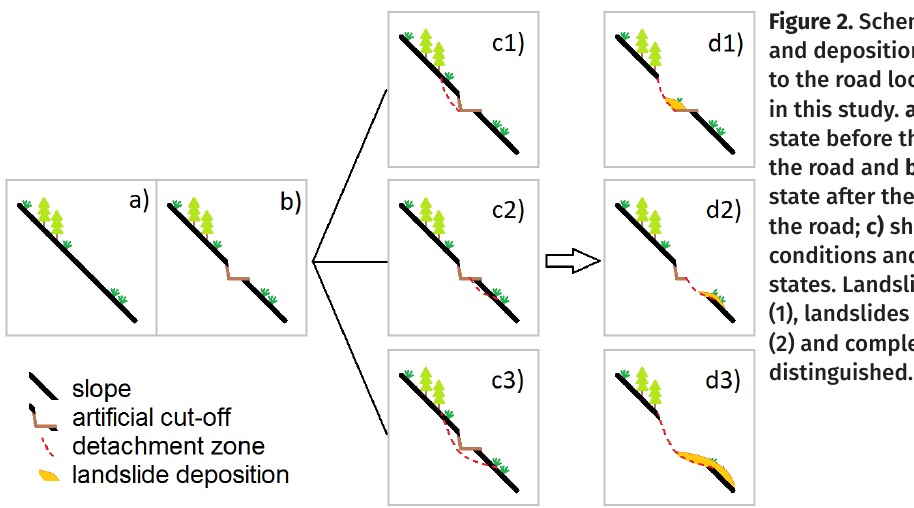
Figure 2. Schematic types of release and deposition zones (in